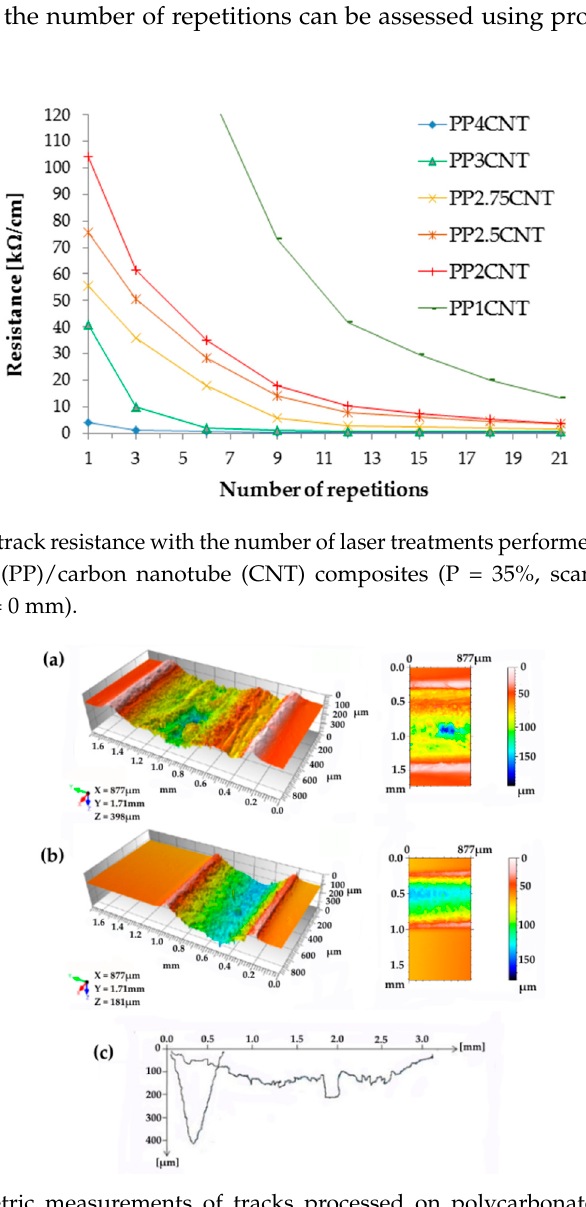
Figure 3. Decrease in track resistance with the number of laser treatments performed on polypropylene–ethylene copolymer (PP)/carbon nanotube (CNT) composites (P = 35%, scan rate = 200 mm/s, F = 15 kHz, defocus = 0 mm).